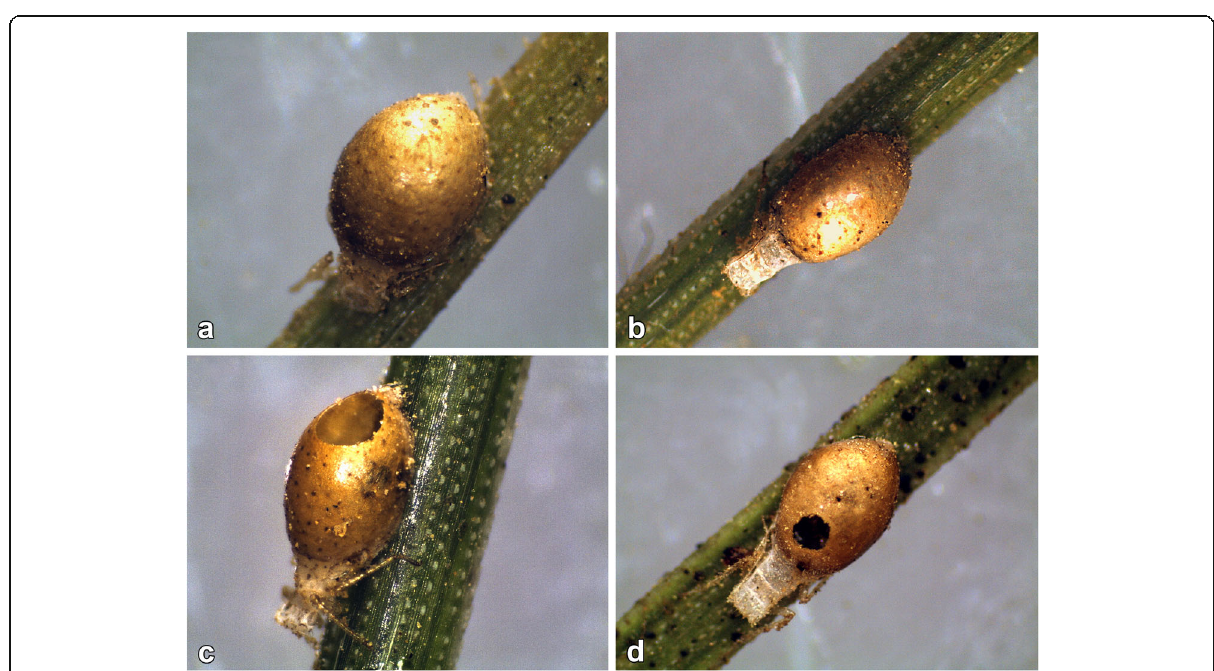
Fig. 3 Parasitized individuals of Eulachnus agilis (Kaltenbach). a , b Matured mummified aphid parasitized by Diaeretus leucopterus (Haliday). c Mummified aphid with emergence hole by the adult parasitoid at the postero-dorsal area. d Emergence hole of a hyperparasitoid, Asaphes suspensus (Nees), at the anterio-dorsal area of the